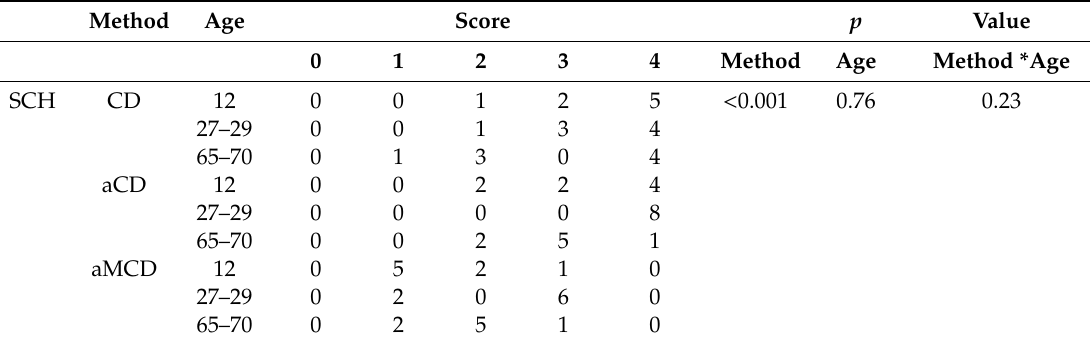
Table 10. Macroscopic evaluation of subcutaneous hemorrhage (SCH) at the site of dislocation. Number of birds with each score are